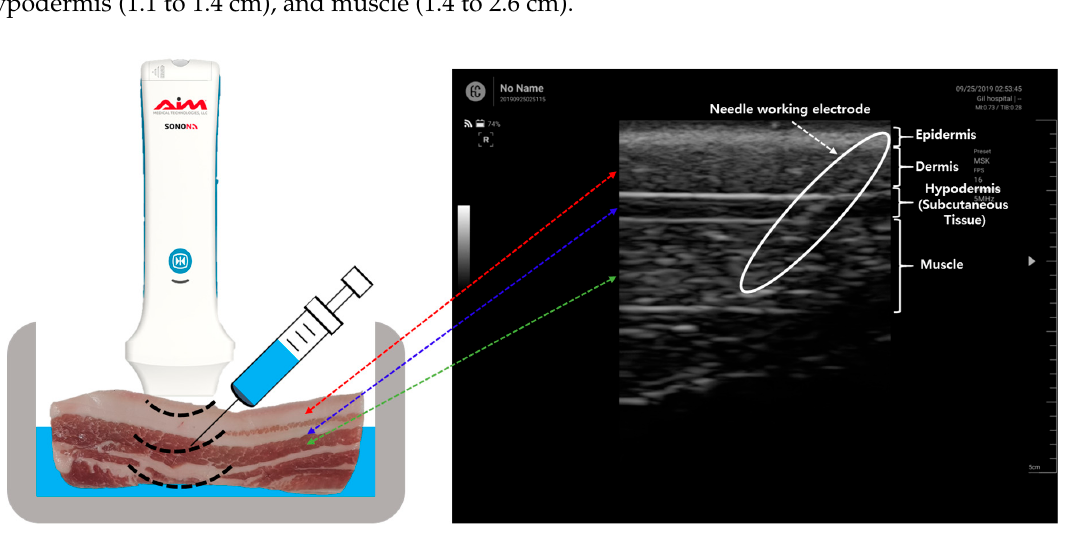
Figure 3. Ultrasound image of the needle insertion in the tissue layer.